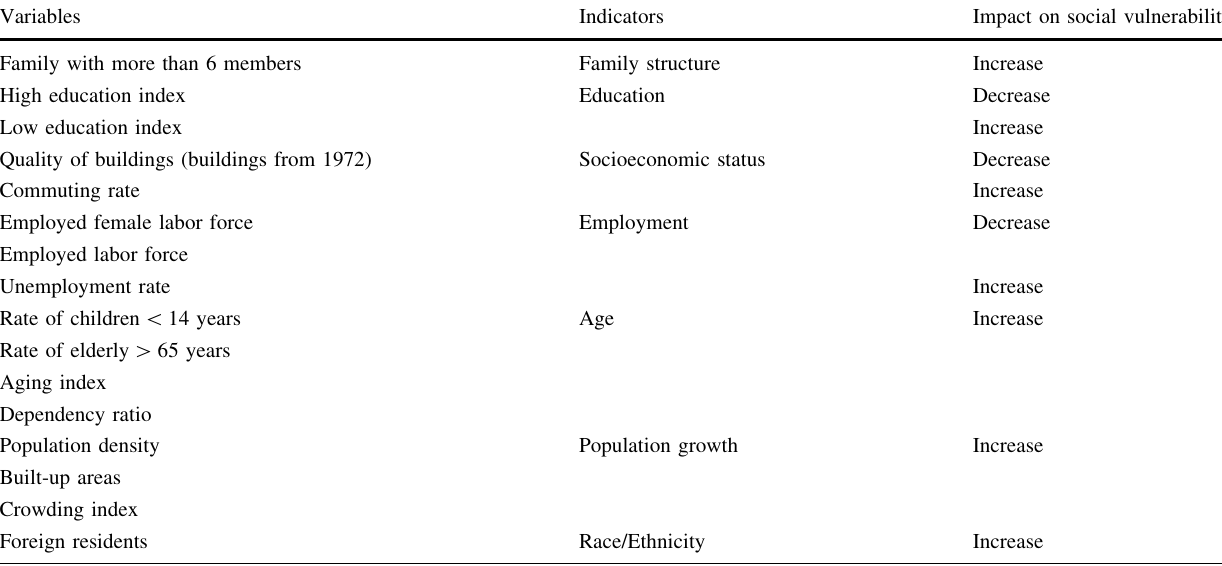
Table 1 Variables used in the social vulnerability index for